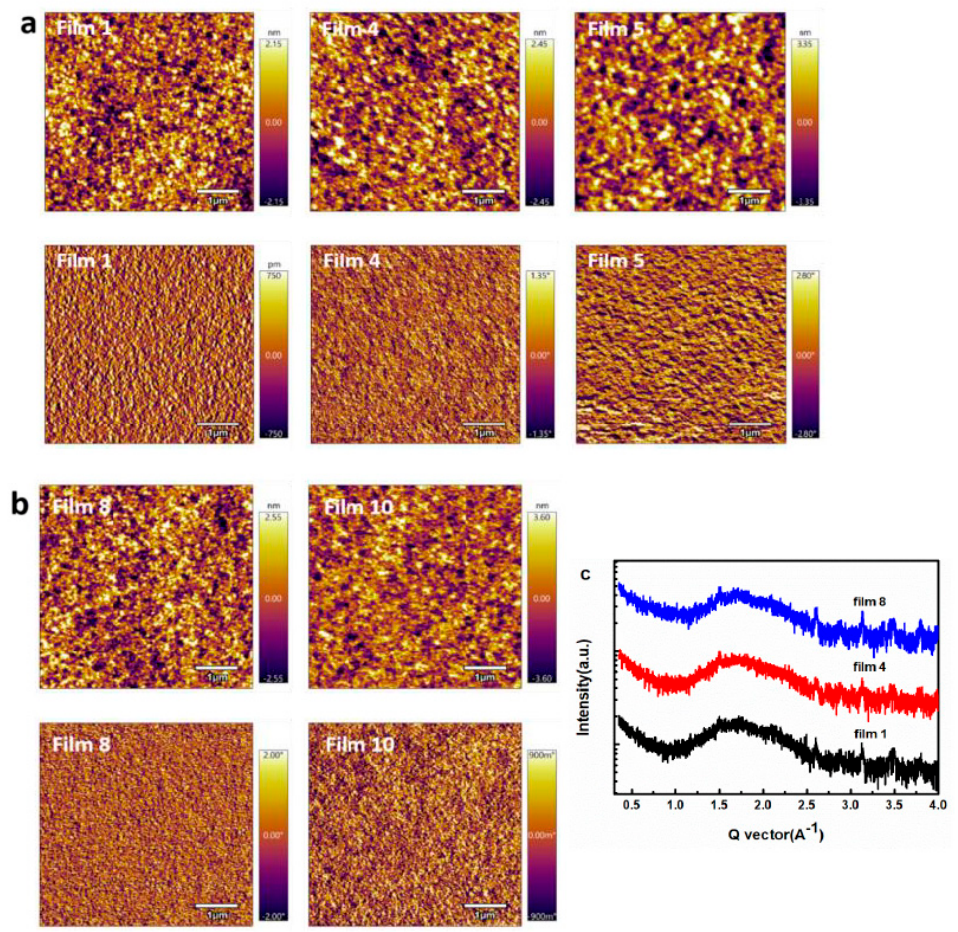
Figure 4. AFM topography images (above) and the corresponding phase images (below) of 5 × 5 µ m 2 area of ( a ) film 1, film 4, film 5, ( b ) film 8 and film 10, ( c ) GIXRD with out-of-plane scattering geometry for film 1, 4,